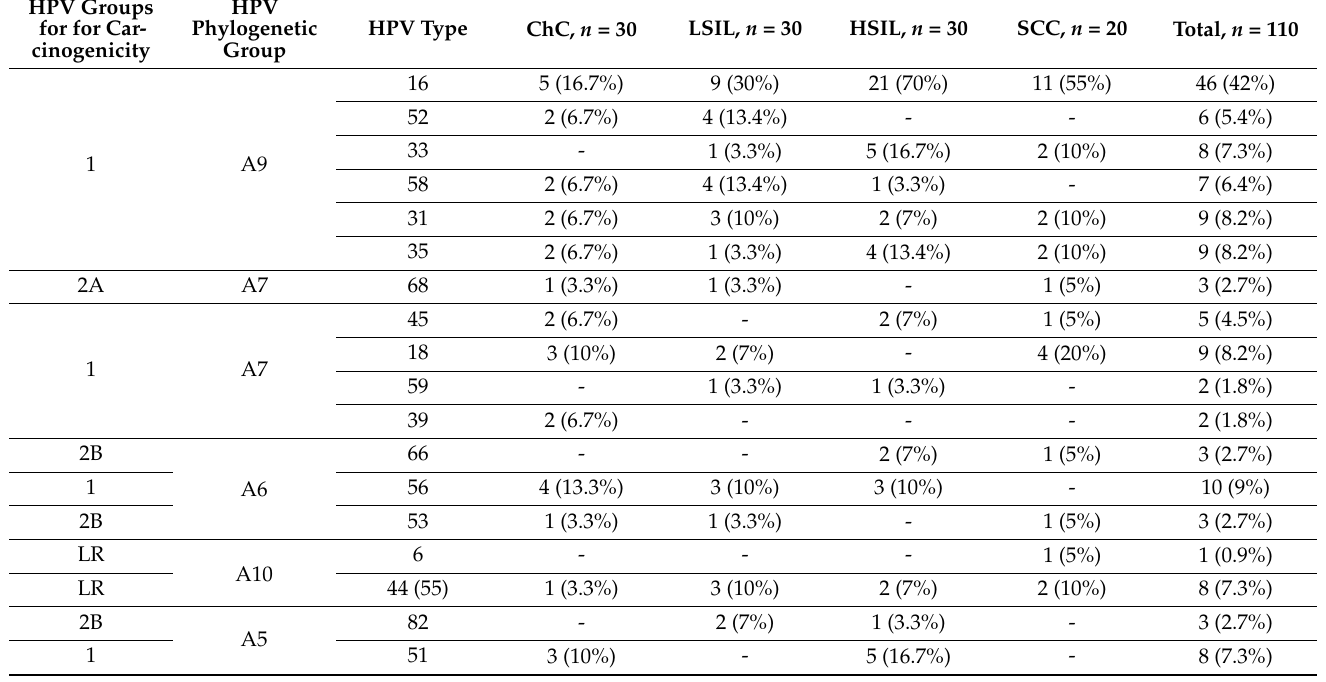
Table 3. Results of HPV testing in study groups according to the IARC carcinogenicity